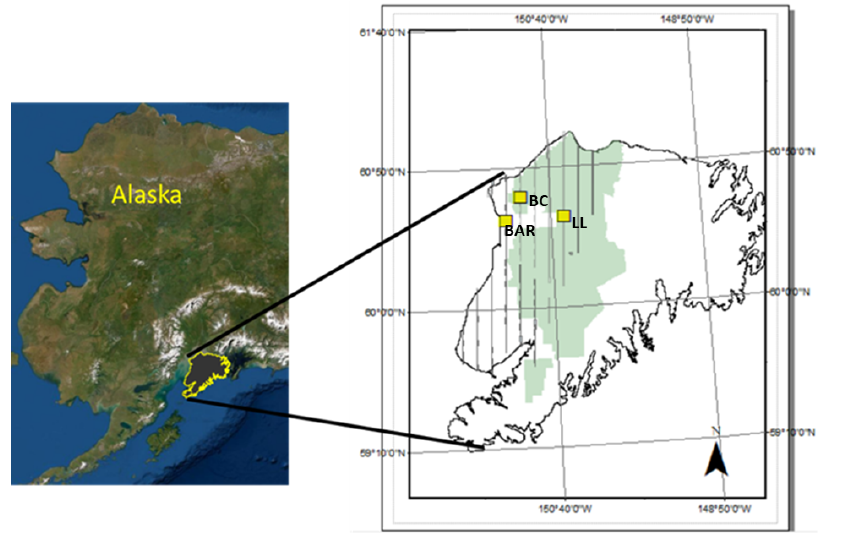
Figure 1. A map of Alaska (left) with the Kenai Peninsula outlined in yellow. On the right, the map of the Kenai Peninsula shows the National Wildlife Refuge (green), the 2014 flight campaign of NASA Goddard’s LiDAR Hyperspectral Thermal mission(G-LiHT) (grey bars), and the approximate location of the three sampling sites (BAR, Bridge Access Road; BC, Beaver Creek; LL, Lily Lake) referenced in this research (yellow boxes).